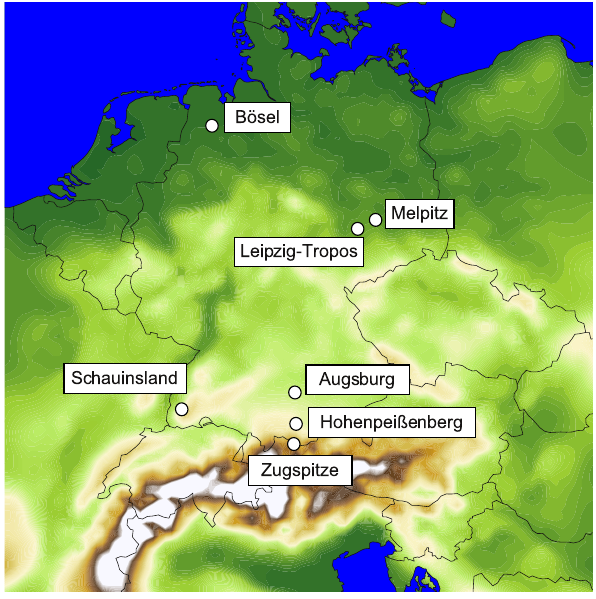
Figure 1. Locations of observation sites of C soot mass concentra- tion and light absorption in model domain D02 for model evalua- tion.